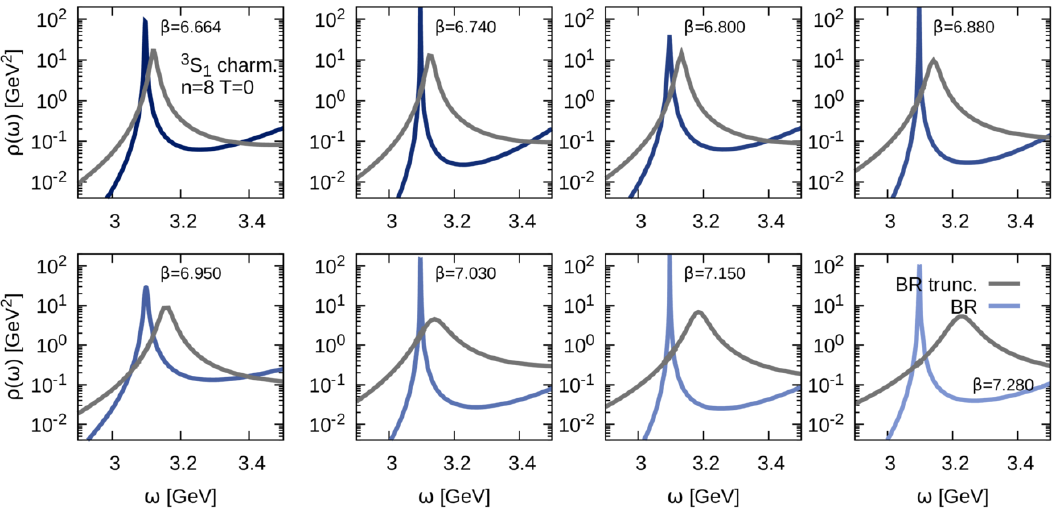
Figure 37 . In(cid:13)uence of truncating the low-temperature simulation data to the same (cid:28) max =a (cid:28) = 12 Euclidean time extent available at (cid:12)nite temperature for charmonium 3 S 1 channel. The full reconstruction is given by colored solid lines, while the result after truncation is given by the gray solid curves.